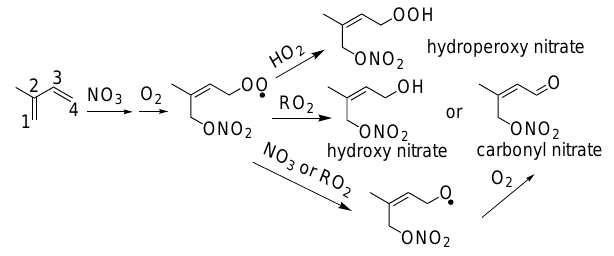
Figure 1. Organic nitrates produced from NO 3 -initiated isoprene oxidation.